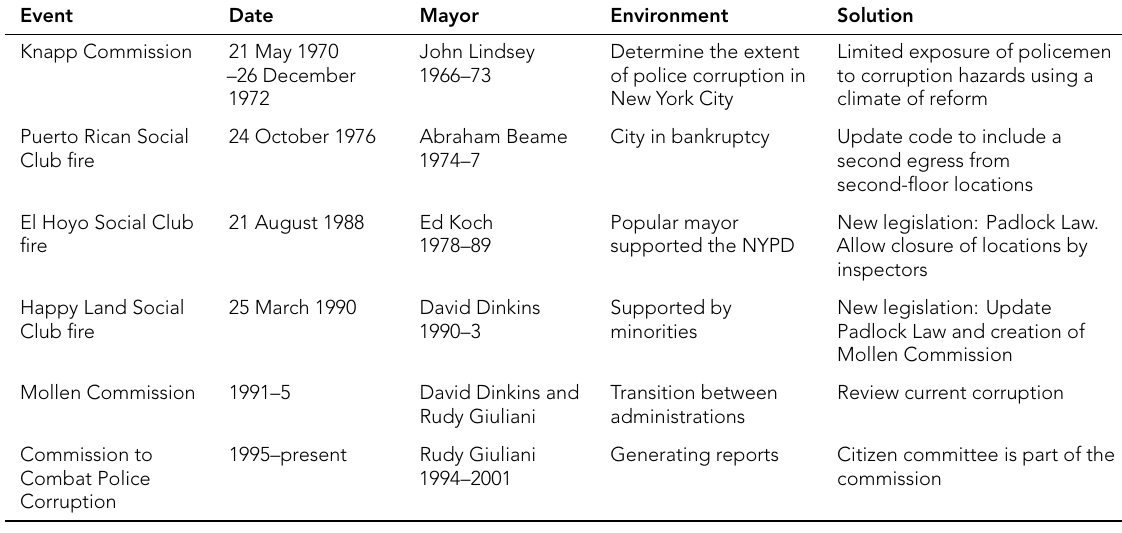
Table 1. Events and commissions (Source: